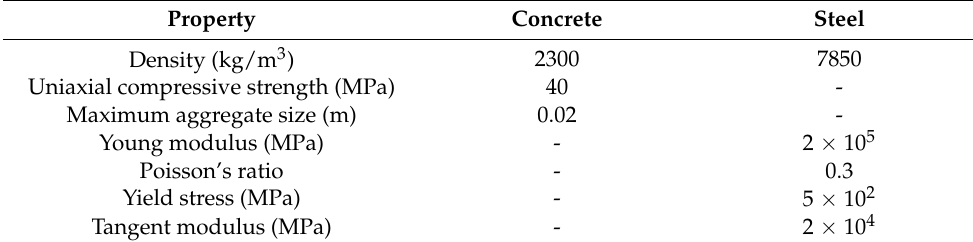
Table 3. Concrete and steel properties used in the numerical